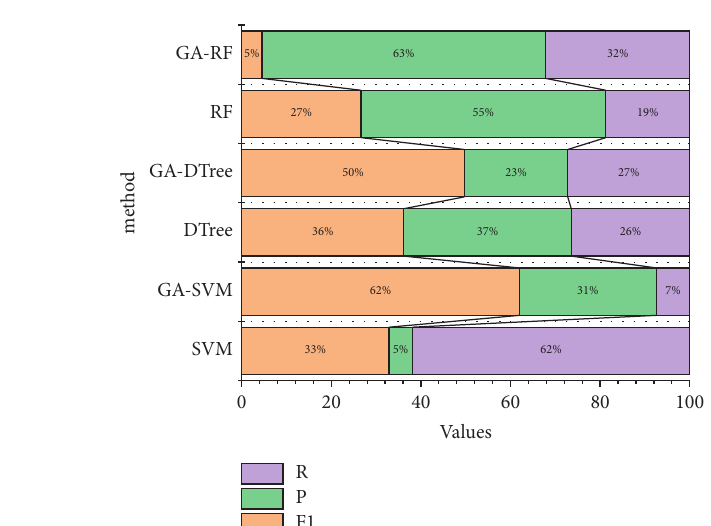
Figure 5: Evaluation of different classification models for internal and external